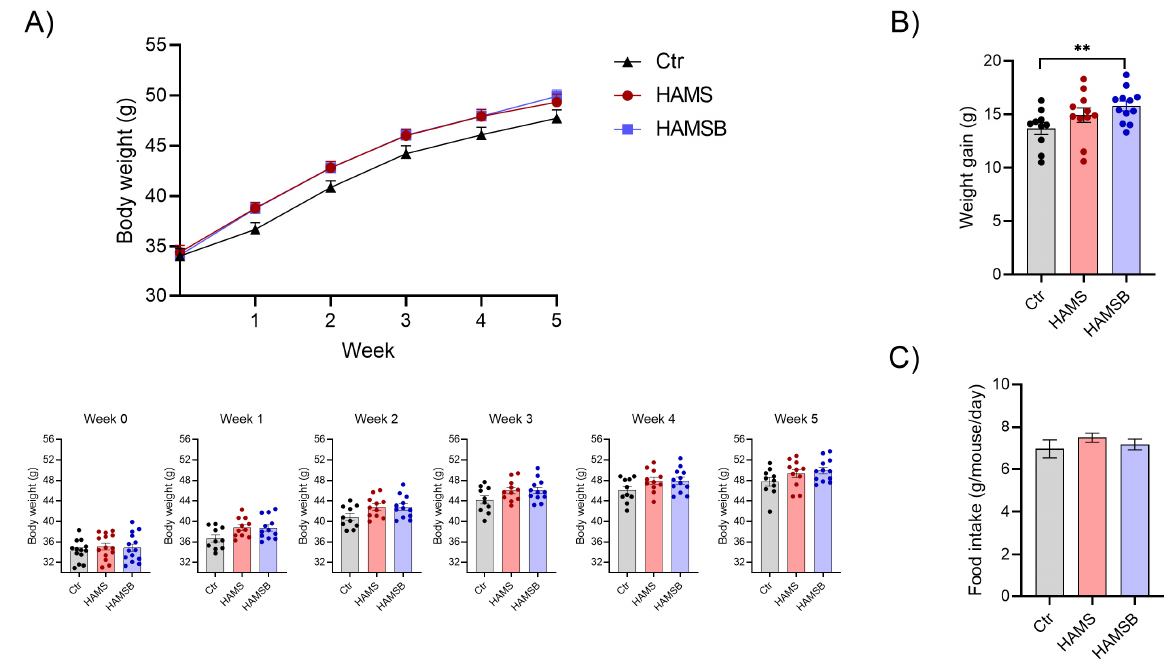
Figure 3. Bodyweight and food intake. ( A ) Weekly measurements of body weight in db/db mice fed a control diet or a diet supplemented with either HAMS or HAMSB. Body weight for each individual mouse in the different weeks are shown below the weight curve. ( B ) Total weight gain at the end of the 5-week feeding period. ( C ) Food intake is shown as gram per mouse per day. Bars show the mean ± SEM. ** p < 0.01. Each circle represents an individual mouse.